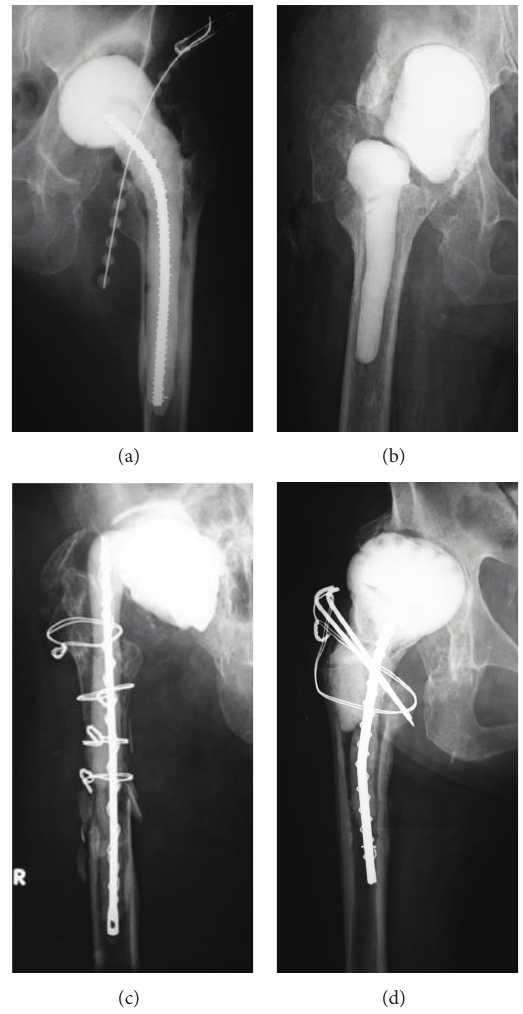
Figure 1: (a) The conventional polymethylmethacrylate (PMMA) cement spacer. (b) The 𝛼 -tricalcium phosphate (TCP) spacer. (c) The separately prepared PMMA cement spacer (femoral side) and 𝛼 -TCP spacer (acetabular side). (d) The new type of antibiotic- impregnated spacer.